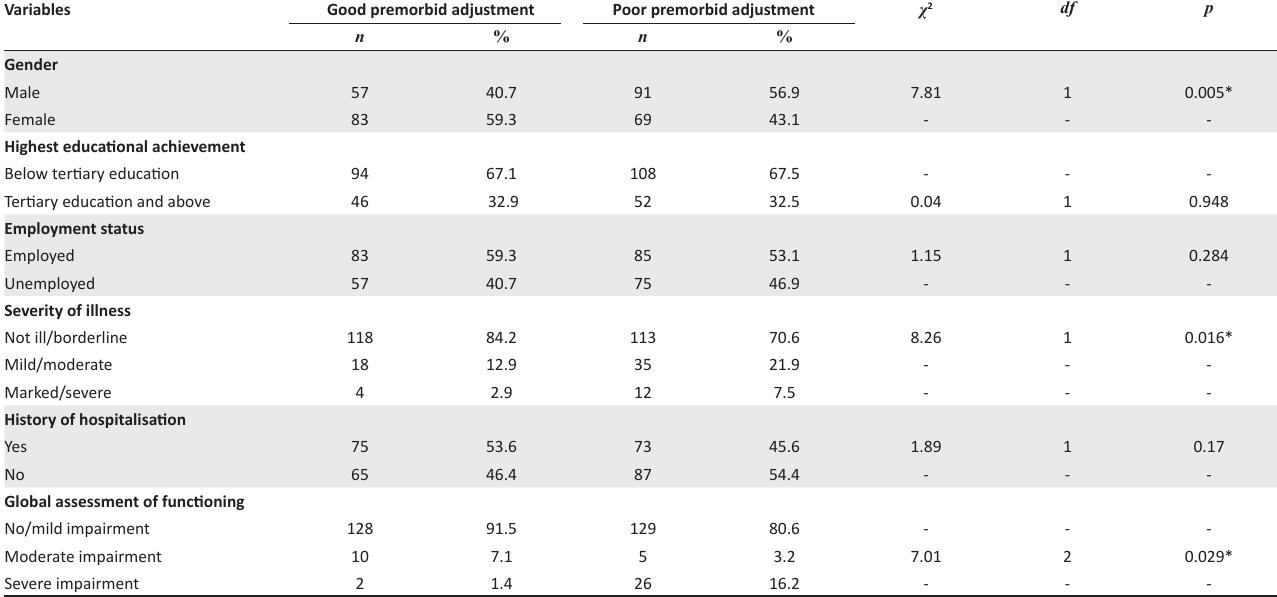
TABLE 3: Socio-demographic and clinical correlates of premorbid adjustment.